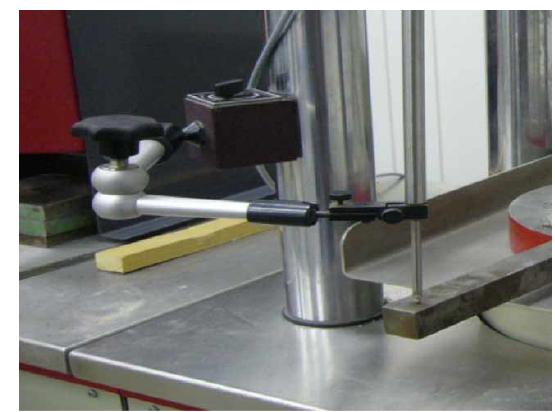
Fig. 1. Crack/rubber interaction in concrete specimens with rubber particles after failure (Segre et al . 2006) Fig. 2. Sample deflection measuring